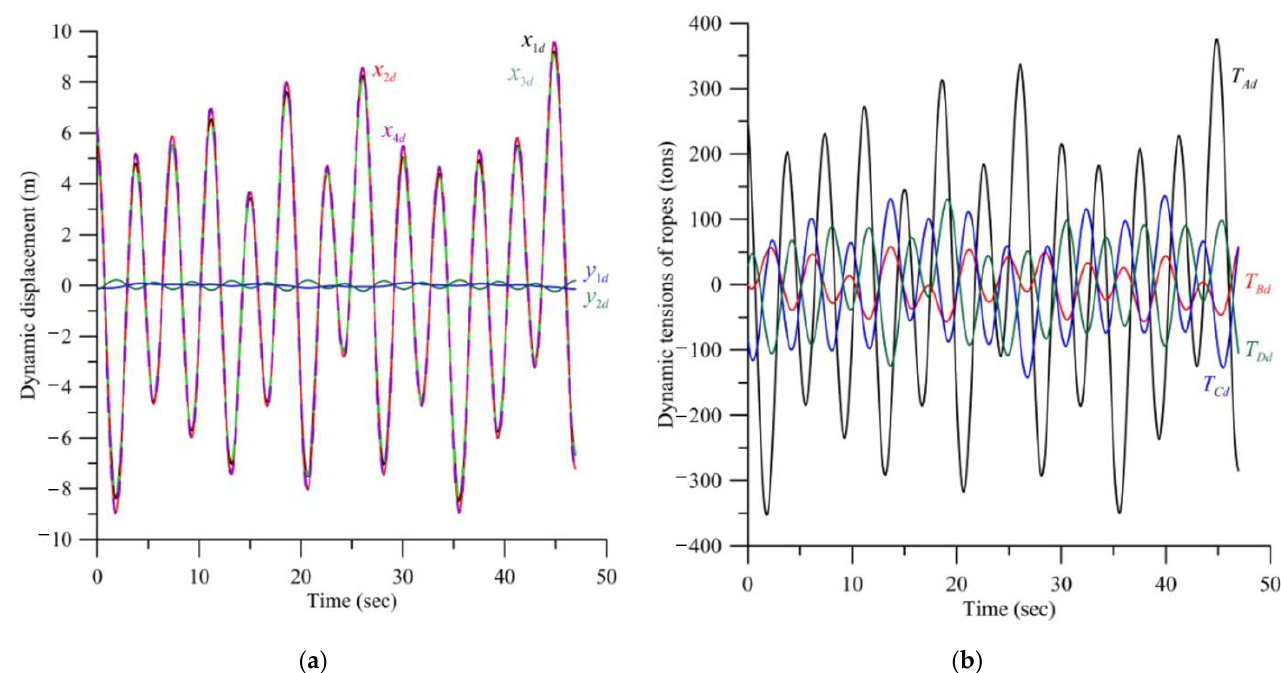
Figure 11. ( a ) Dynamic displacements of the four elements and ( b ) dynamic tensions of ropes under typhoon irregular wave for L C = 150 m, L D = 60 C